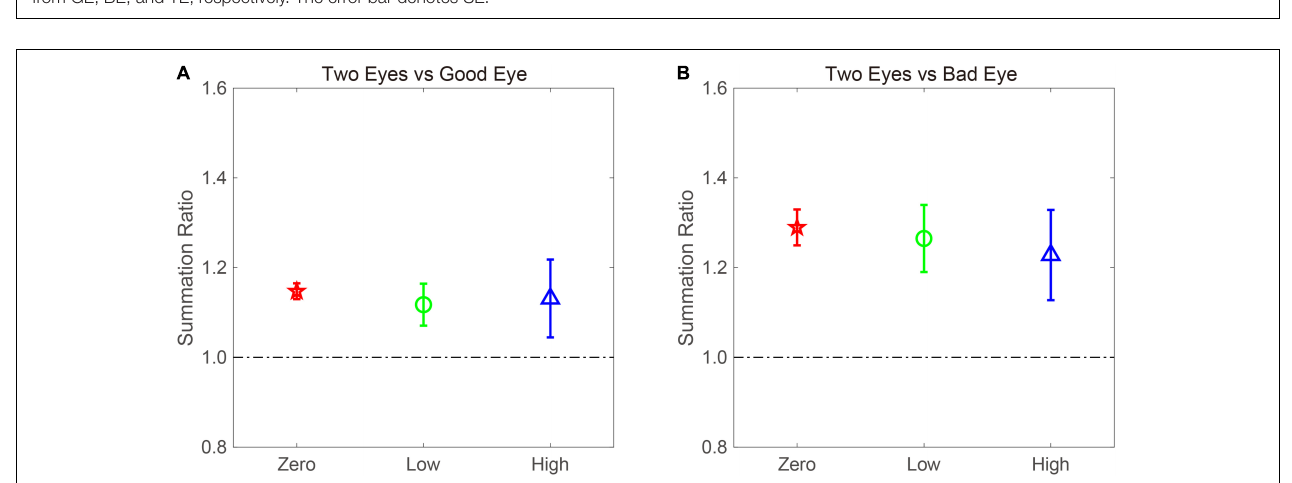
FIGURE 4 | AULCSF-based binocular summation ratios (BSRs) when the (A) good and (B) bad eyes were considered as the standard eyes, respectively. Red, green, and blue colors denote the zero-, low-, and high-noise conditions, respectively. The error bar denotes SE.